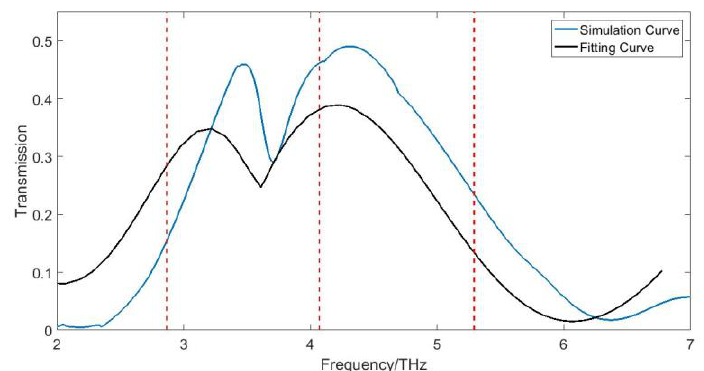
Figure 9. Comparison of sample simulation curve and fitted curve. Table 1. Comparison of actual production and theoretical design of the filtering effect of the terahertz wideband filter.